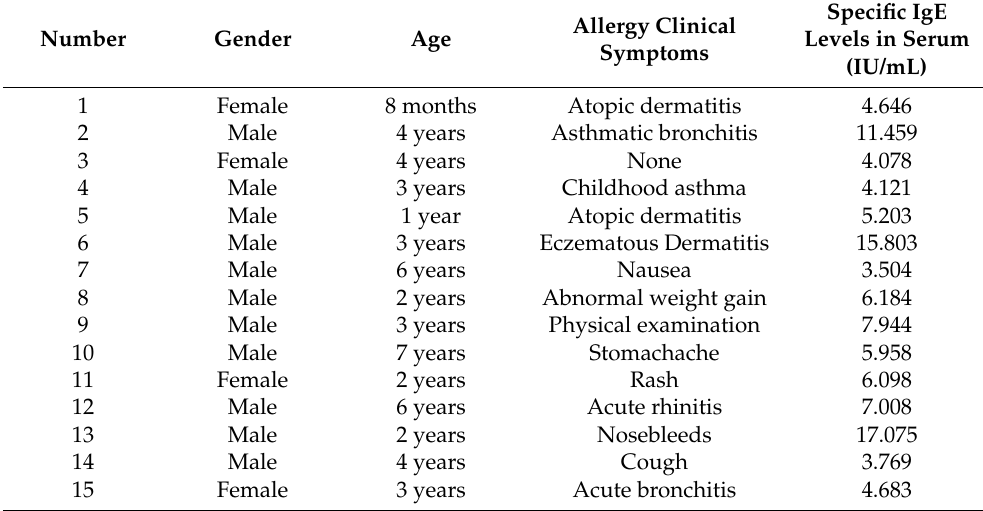
Table 1. The information of donors with cow’s milk